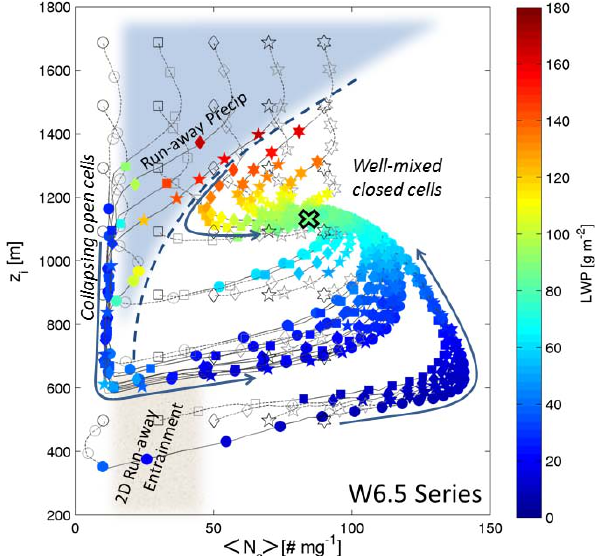
Fig. 10. Phase plane plot for slow evolution of control run W5/NA100. Symbols represent 12h box averages and are colored by LWP. Initial condition is showed as an unfilled symbol in black, while first and second 12h averages are shown in unfilled light grey, where the vertical profile of cloud and LWP is still undergoing an initial fast adjustment.